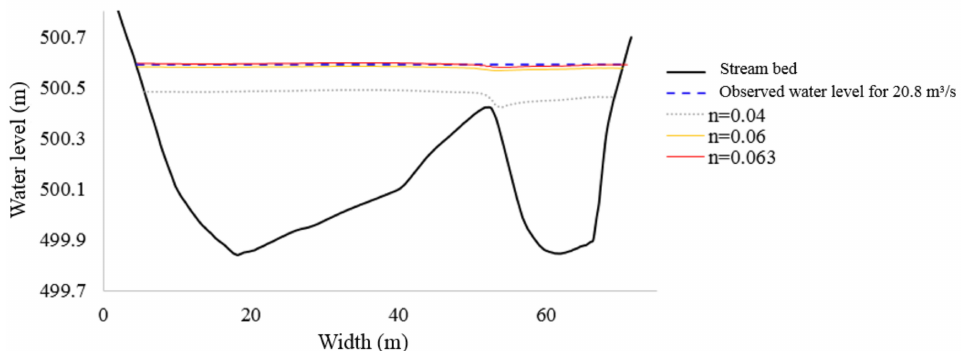
Figure 9. Gauging and calibration section for the Pejibaye river channel, calculated and observed water levels used for model calibration as a function of channel